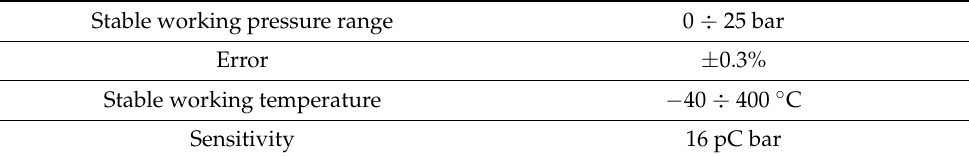
Table 4. Specification of the GH13Z-31